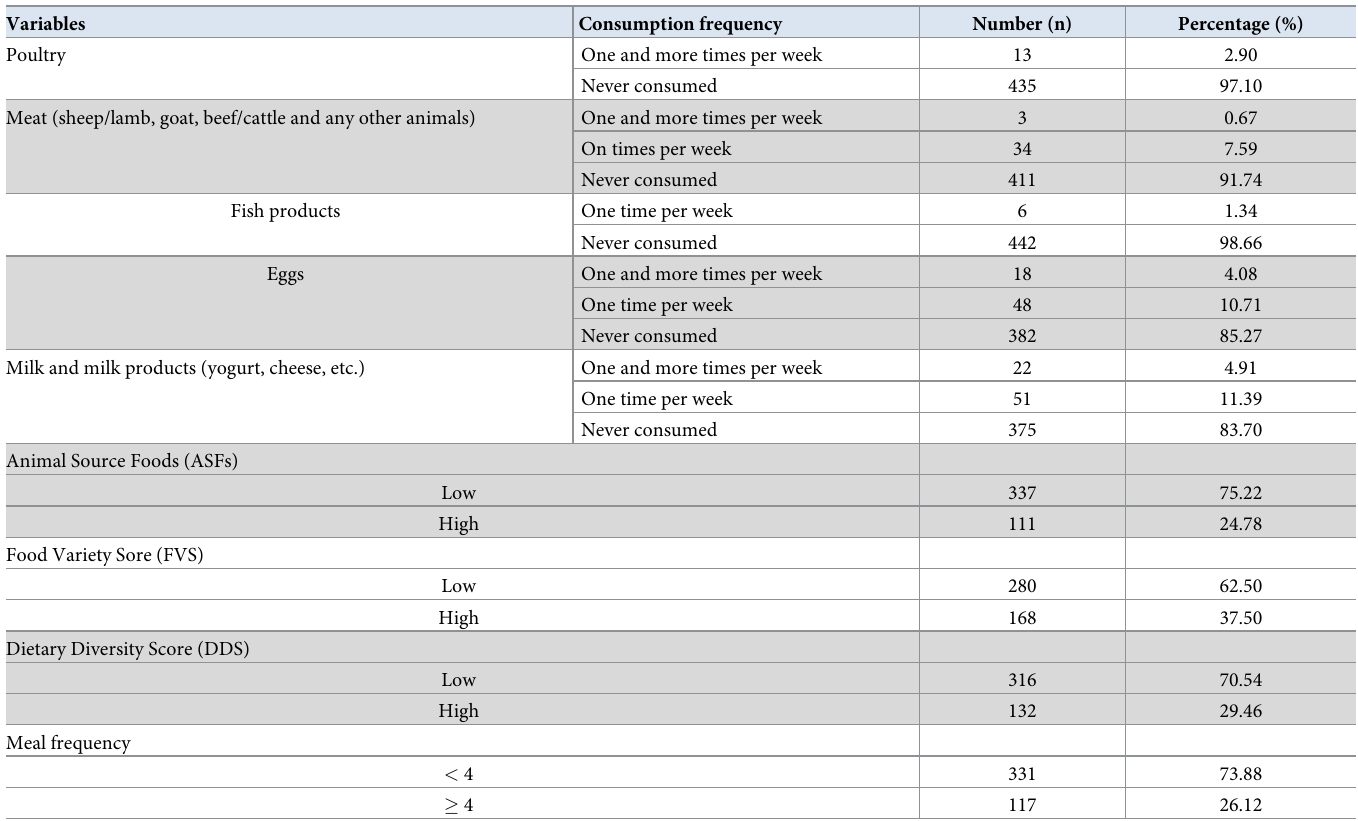
Table 2. Consumption of ASF by pregnant women in Haramaya District, eastern Ethiopia, 2021 (n =